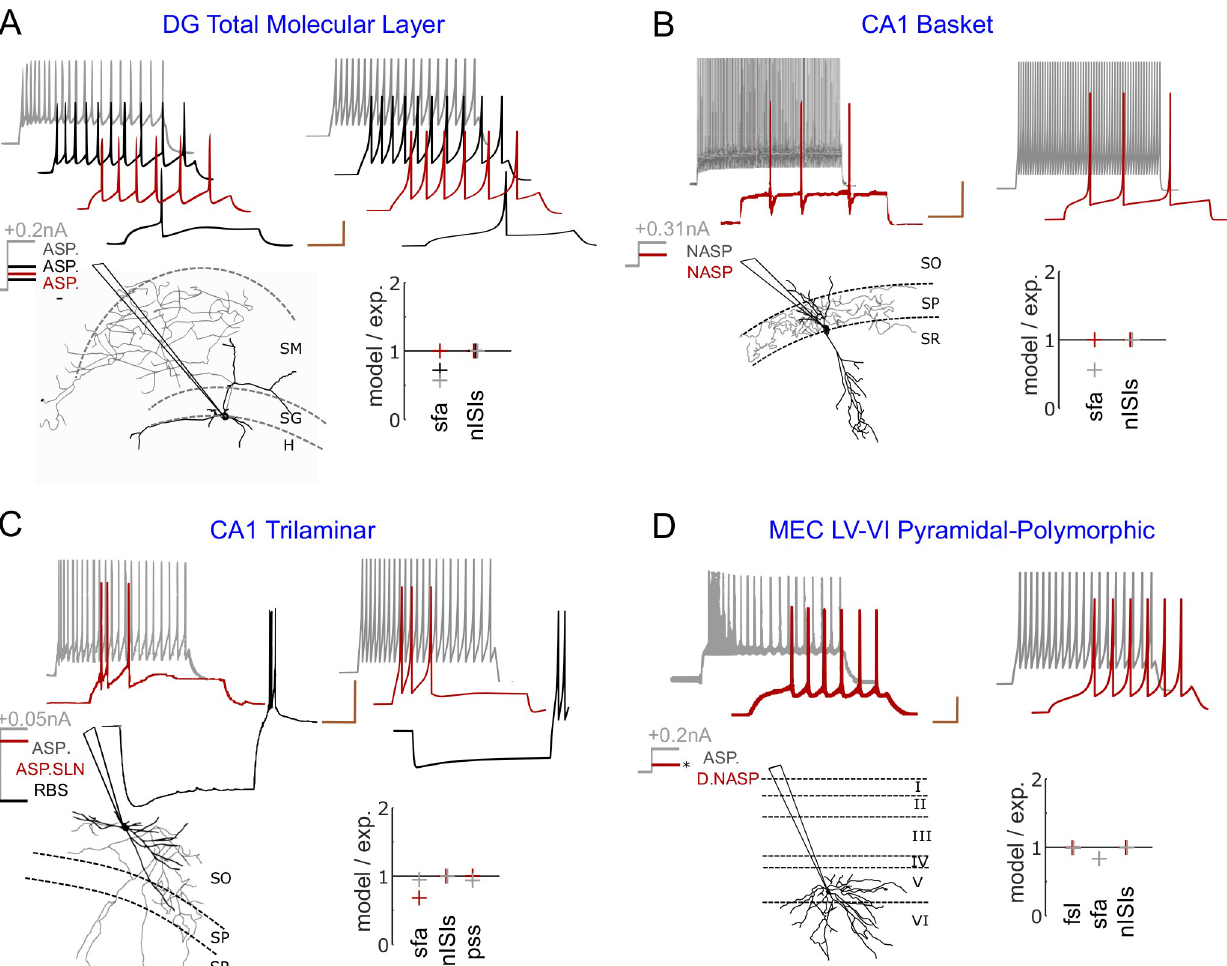
Fig 1. Exemplar models of continuous spiking phenotypes. Each panel displays experimentally recorded voltage traces in the top-left and their morphological identity and magnitudes of somatic current injections in the bottom-left. Traces were digitized by Hippocampome.org . Morphological abbreviations: SO—stratum oriens, SP—stratum pyramidale, SR—stratum radiatum, SM—stratum moleculare, SG—stratum granulosum, H–hilus. Model responses for similar input currents ( ± 0.01 nA from experimental input) are given in the top-right and the goodness-of-fit is given (only) for key features in the bottom-right (S2 Table reports goodness-of-fit for all features). The traces are highlighted in different colors to visually compare experimental and model responses, and to identify the input current and key features for each trace. Calibration bars denote 200 ms and 20 mV in all panels. ( A ) Simple phenotype of a dentate gyrus (DG) Total Molecular Layer neuron that elicits ASP. patterns under three different input currents [25]. The digitally reconstructed morphology was reproduced from NeuroMorpho.Org [26]. ( B ) Simple phenotype of a CA1 Basket neuron that elicits patterns of class NASP for +0.15 nA and +0.31 nA [27]. Note that sfa in the red trace is not statistically significant to qualify this pattern as ASP. ( C ) The phenotype of a CA1 Trilaminar neuron shows different classes of patterns for +0.025 nA and +0.05 nA [27]. In addition, this neuron elicits rebound spikes (RBS) for a hyperpolarizing input of -0.1 nA . ( D ) The phenotype of a medial-entorhinal cortex (MEC) neuron shows different classes of patterns for +0.2 nA and an unknown input (denoted by ‘ � ’) just above its rheobase [28]. All experimental traces are whole-cell patch clamp recordings.